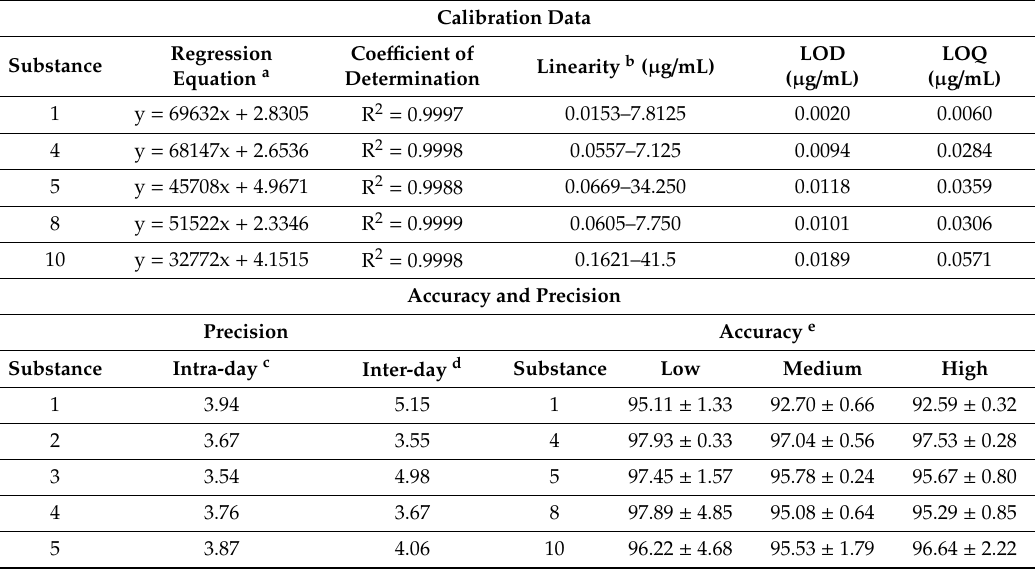
Table 1. Validation parameters of the HPLC